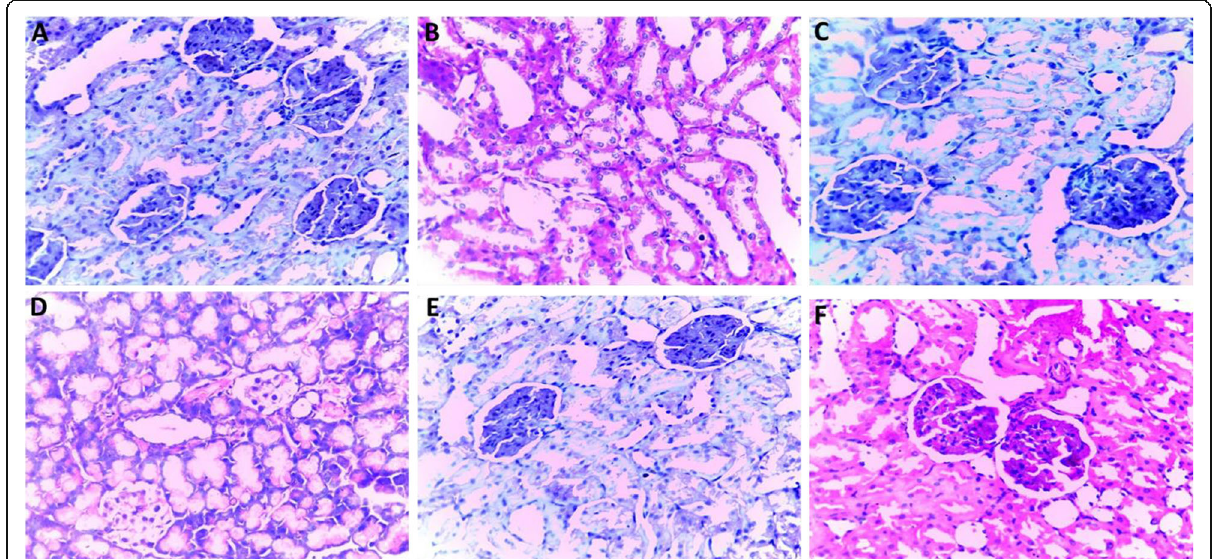
Fig. 6 Microscopic observation of the kidney in the experimental tissue section. a Normal control-light micrographs of rat kidney tissue in normal kidney depicted normal renal corpuscle with glomerulus and architecture. b Diabetic control-nonappearance of renal corpuscle, glomerulus, and abnormal architecture. c Diabetic+glibenclamide-various regions of the kidney tubules appeared to be normal without any changes in the mesangial matrix. d Diabetic+EEPM (50 mg/kg) section of kidney showing few changes compares with normal control and less appearance of cells. e Diabetic+EEPM (100 mg/kg) and (F) diabetic+EEPM (200 mg/kg) various regions of kidneys of treated animals revealed absence of matrix expansion and glomerular basement membrane thickening; suggesting became normal histoarchitecture of renal